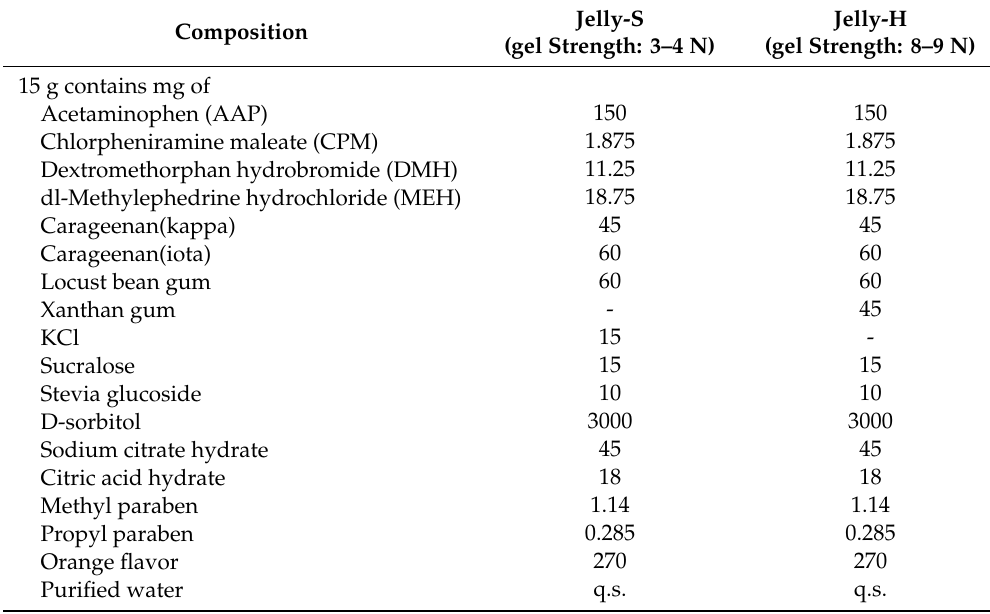
Table 1. Composition of oral